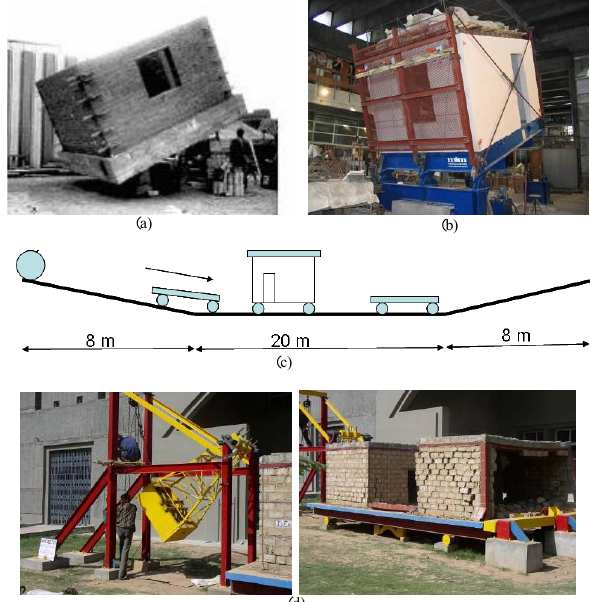
Fig. 2 Different masonry testing setups Fig. 2. Different masonry testing setups. (a) Tilting test setup (Ze- table (Keightley, 1986). (d) Pendulum and vibration table (source: Jagadish, 2002).